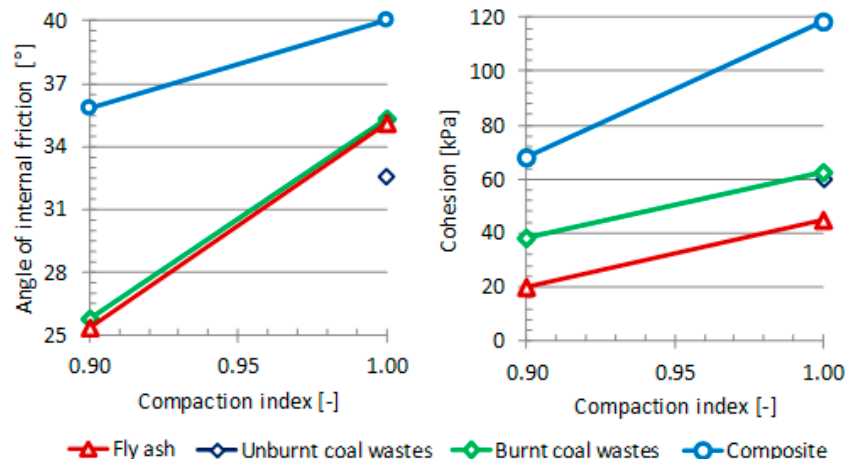
Figure 6. Influence of compaction on the angle of internal friction and cohesion.